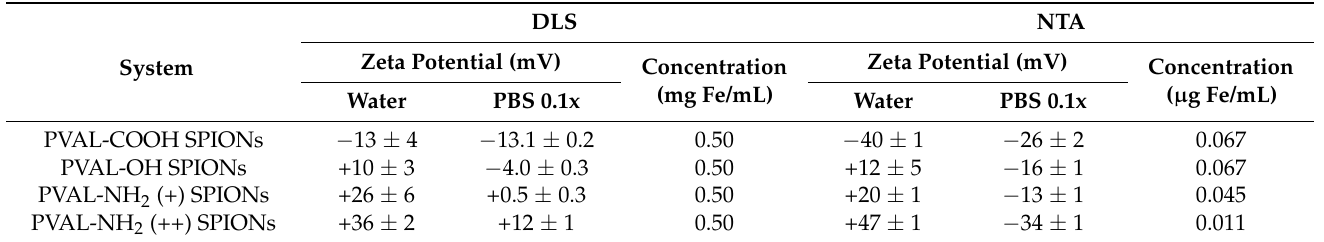
Table 2. Zeta potential measurements by the DLS and NTA. All values are averaged from 3 different